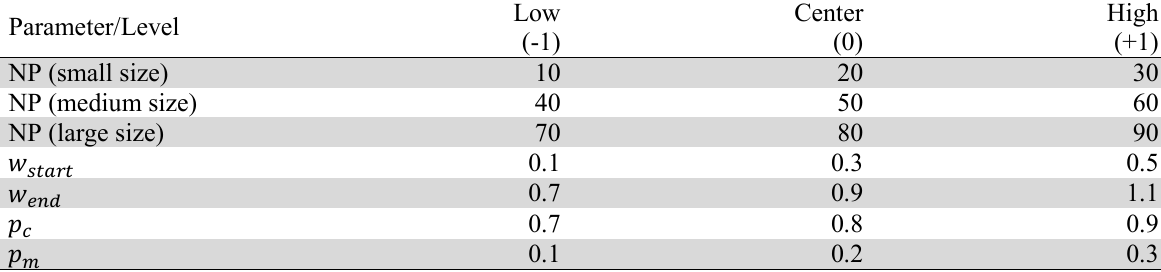
The levels of the values of each parameter for PSO-GA Parameter/Level